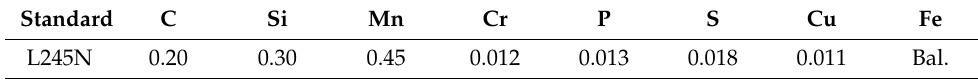
Table 1. The elemental compositions of L245N standard steel, (wt. %).